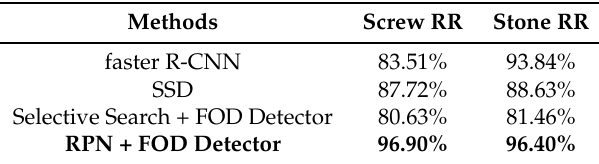
Table 4. The recall rates of screw and